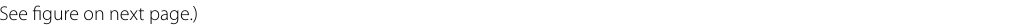
Fig. 2 ToF–SIMS depth profiles of H 3 O + , C 5 H 15 NPO 4 + , C 27 H 45 + , and C 27 H 45 O + peaks in corpus callosum in coronal section and ToF–SIMS images of cholesterol and sulfatide ion peaks of the rat brain tissue. The blue square indicates the position for depth profile acquisition. Depth profiles of H 3 O